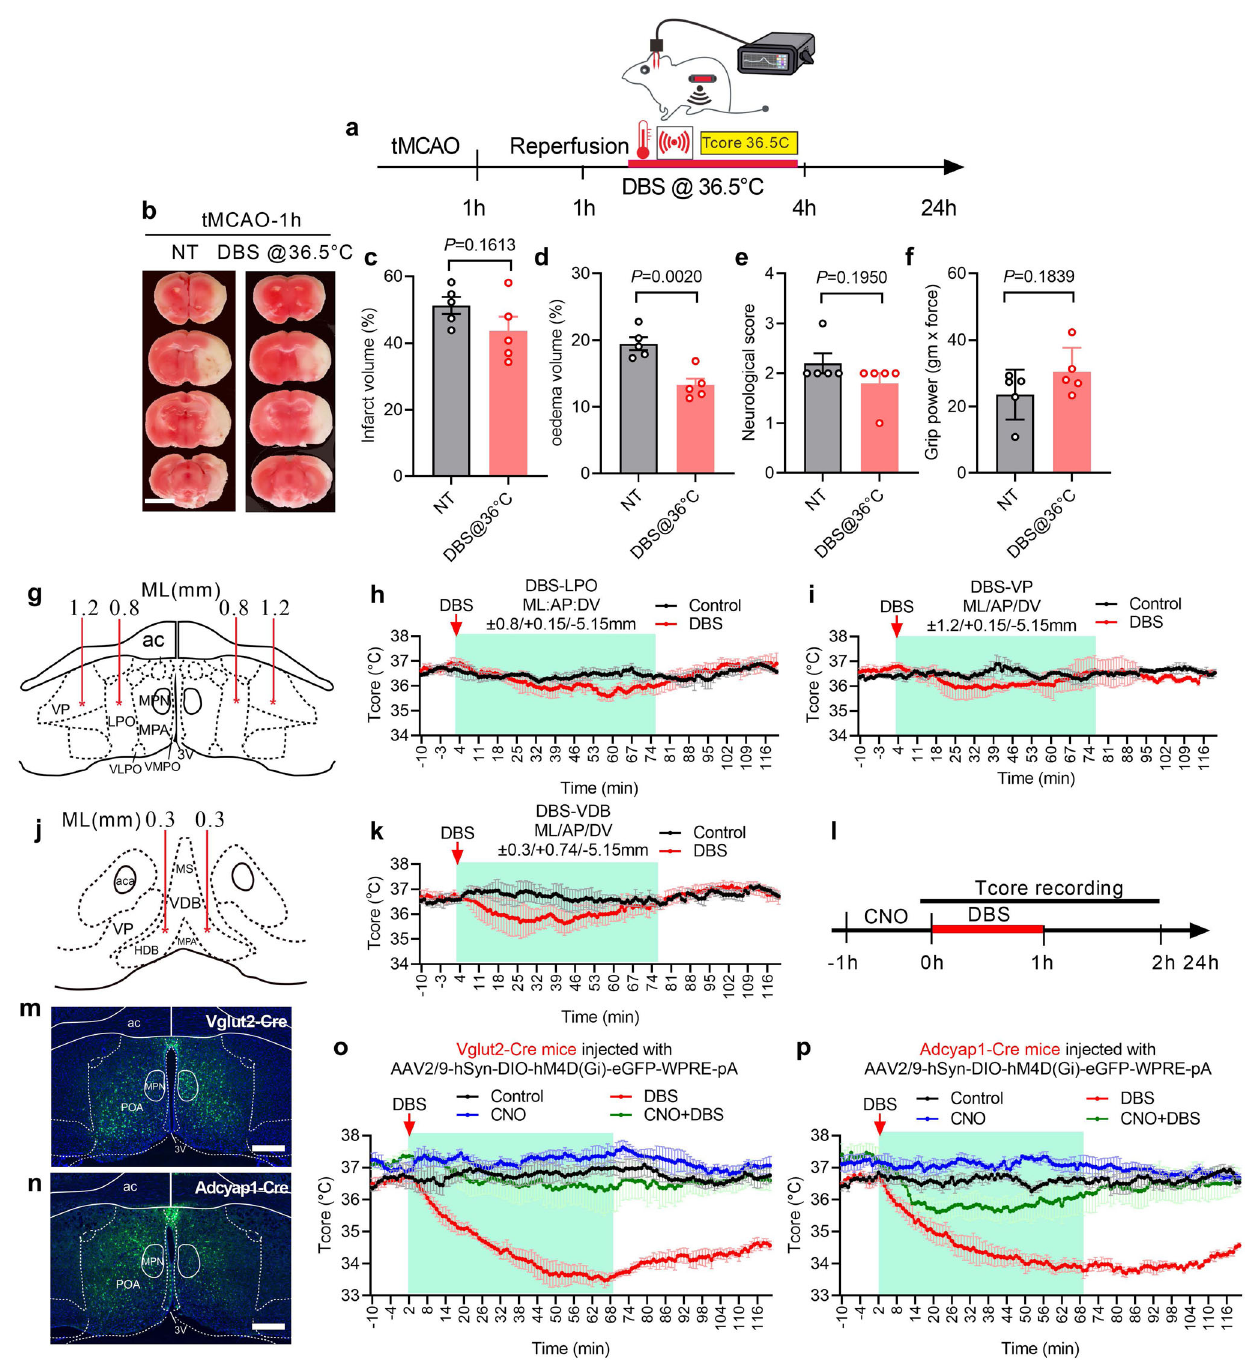
Fig. 4 | Determination of DBS selectivity and speci fi city in T core reduction for brain protection. a Schematic representation of DBS on MPN with T core main- tainedat36.5°C. b Braincoronalsectionsat2mmthicknesswerestainedwithTTC to show viable tissue (red colour) and damaged tissue (white colour). Scale bar= 5mm. c – f Unpaired two-tailed t tests were performed to compare normothermic tMCAO (NT) and DBS of tMCAO brain at 36.5°C (DBS@36.5°C) with volumes of infarction ( c , t(8)=1.543, P =0.1613), oedema ( d , t(8)=4.495, P =0.002), the neu- rological de fi cit scores ( e , t(8)=1.414, P =0.1950), and forepaw grip strength ( f ,t(8)=1.455, P =0.1839).Dataweremean±s.e.m( n =5mice). g , j Schematicofthe POA nucleus on coronal brain sections and the locations of the bilateral DBS